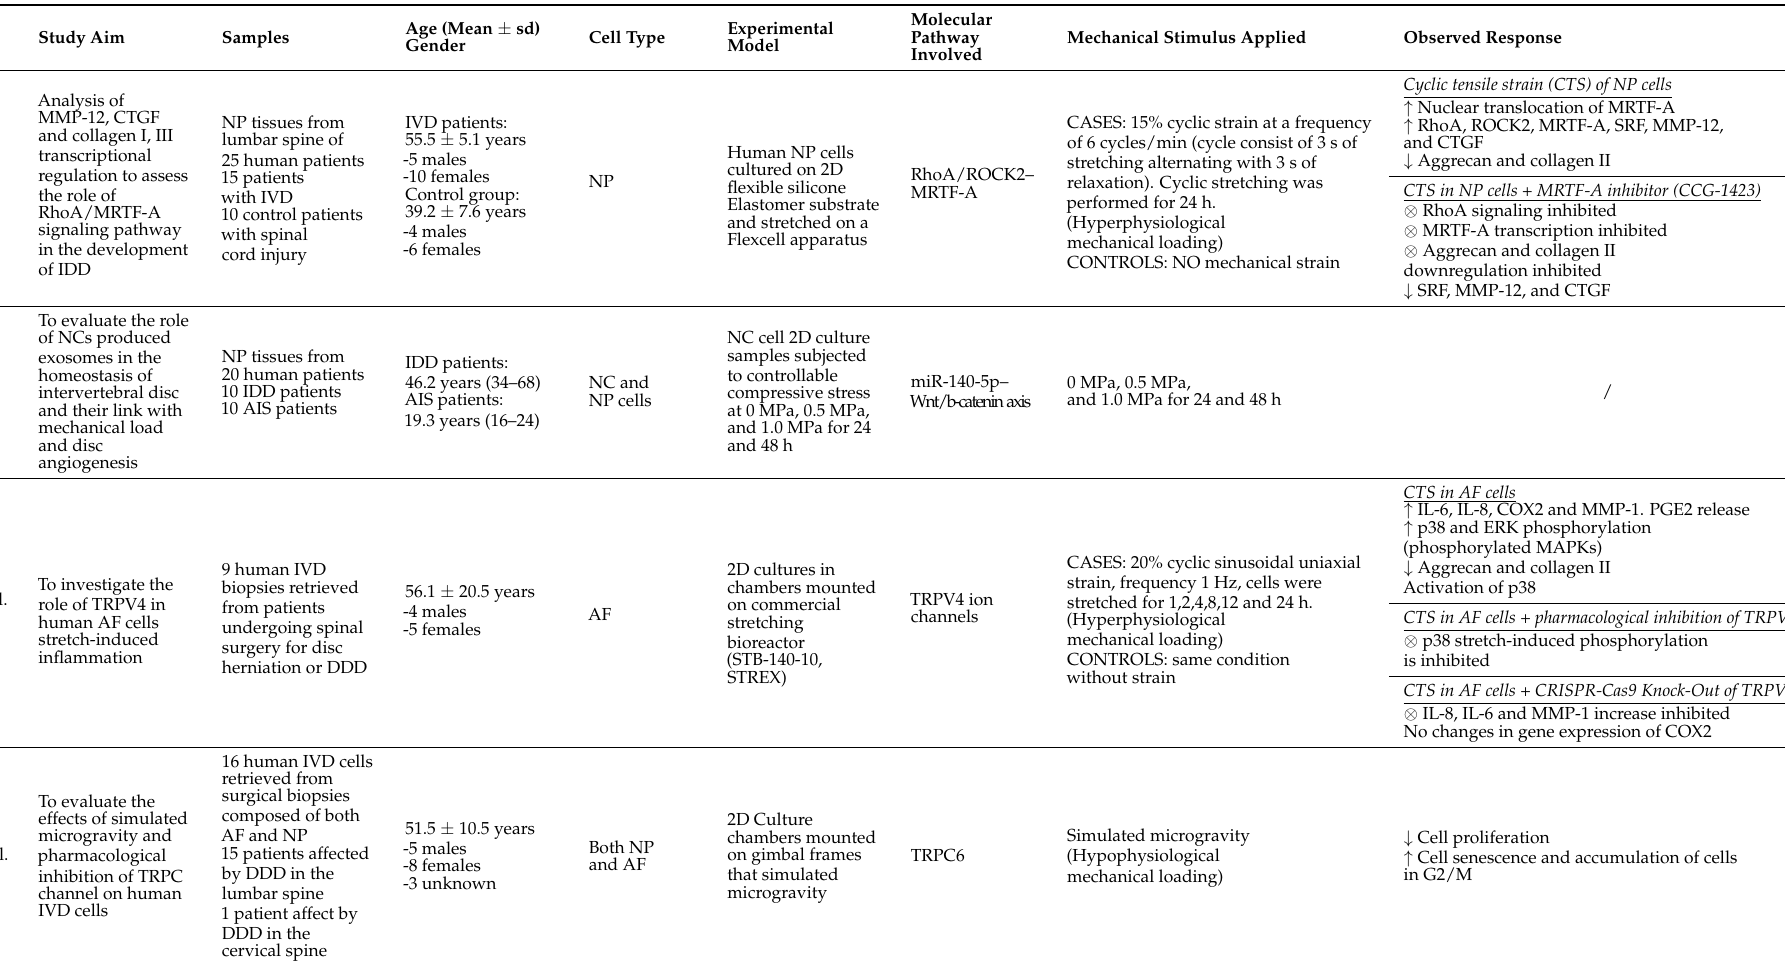
Table 1. Details of the included studies. ↑ Increase of expression, ↓ decrease of expression, ↑↑ high increase of expression, ↓↓ high decrease of expression, ⊗